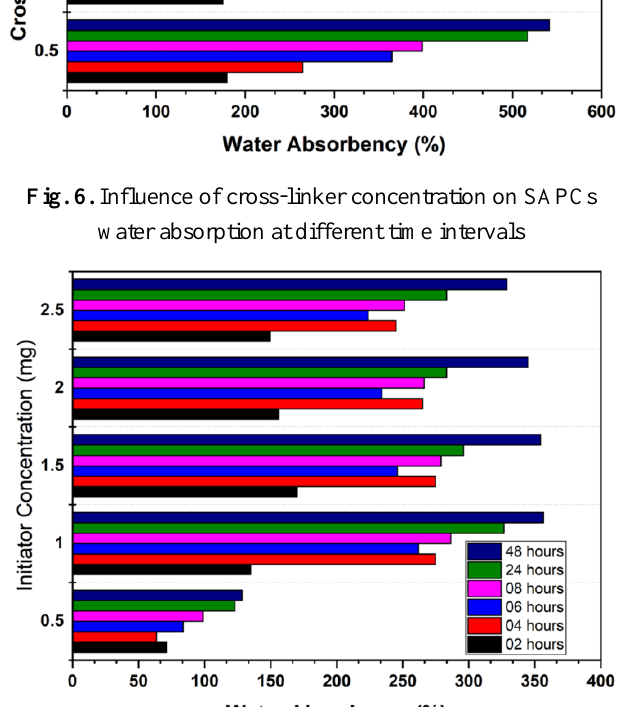
Fig. 7. Influence of initiator concentration on SAPCs water absorption at different time